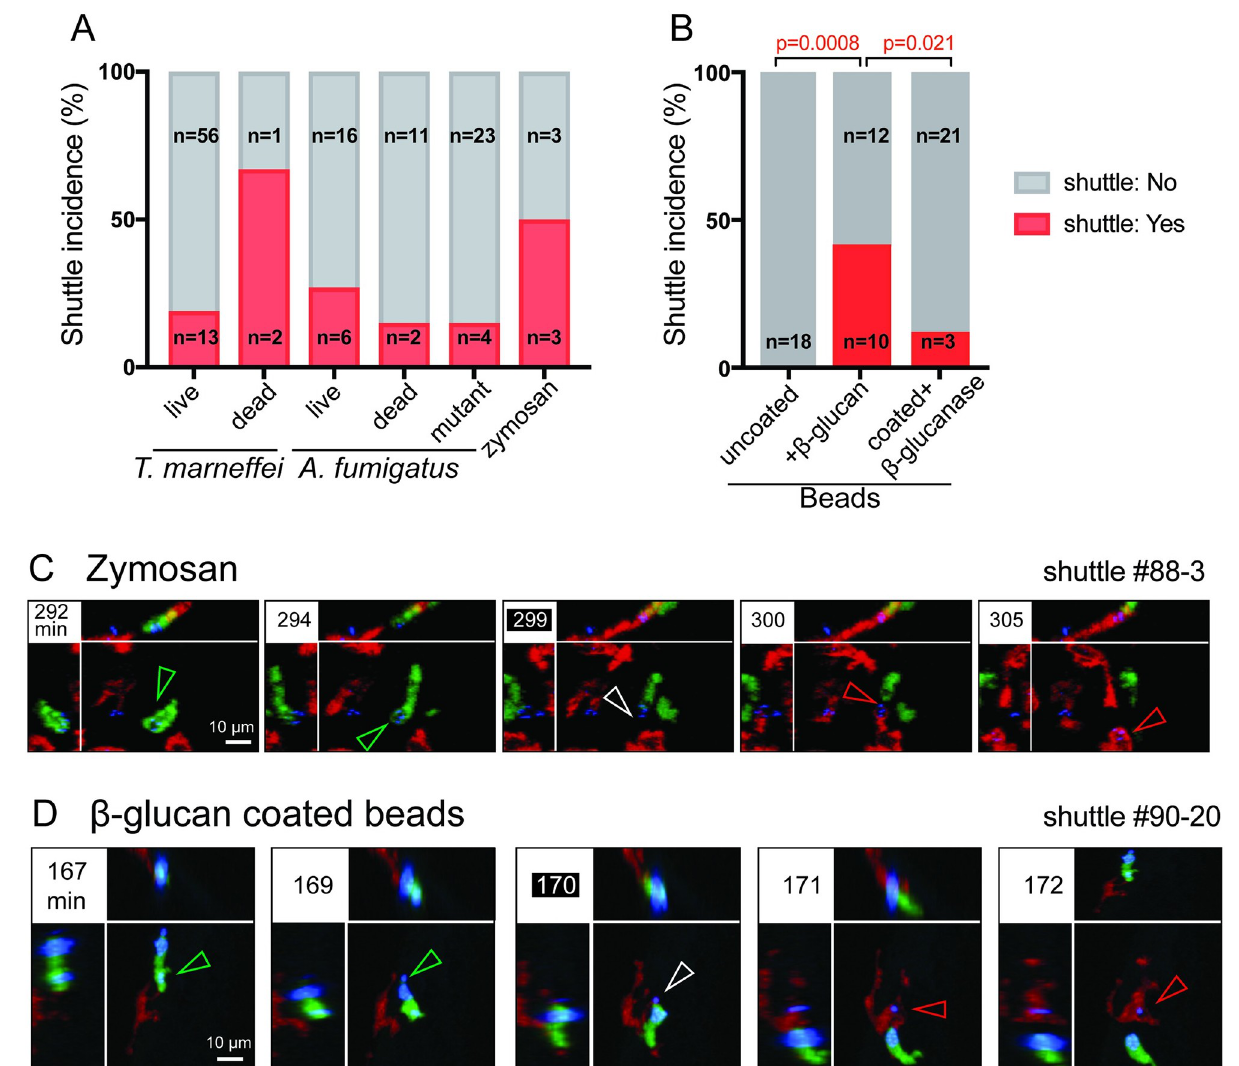
Fig 6. β -glucan is a fungal determinant sufficient to trigger shuttling. (A,B) Relative frequency of shuttles for different cargos, incidence computed for each condition as number of 3-h imaging datasets with shuttle(s)/total number of imaging datasets. By chi-squared analysis, there are no significant differences for the comparisons: live spores of the two species ( p = 0.38), live and dead T . marneffei ( p = 0.31), and dead spores of the two species ( p = 0.34). n -values indicate the number of datasets in each category. (C,D) Images of representative shuttles of zymosan particle (C) and β -glucan– coated plastic beads (D). Shuttles of particles (blue) are from Tg(mpx : EGFP) neutrophils (green) to Tg(mpeg1 : Gal4FF)×(UAS-E1b : Eco . NfsB-mCherry) macrophages (red). In each example, panels include isometric orthogonal yz and xz views corresponding to the xy maximal intensity projection and indicate the time in min from start of movie. Colored arrowheads indicate the conidium within donor neutrophil (green), at the point of intercellular transfer (white) and in the recipient macrophage (red). Scales as shown. Stills in C, D correspond to S5A and S5C Movie, respectively. Datasets for A–B are provided in S1 Data. Eco . Nfsb , E . coli nitroreductase; EGFP, enhanced green fluorescent protein; Gal4FF , engineered form of S . cerevisiae Gal4 transcriptional activator; mpeg1 , macrophage-expressed gene 1; mpx , myeloid-specific peroxidase; Tg , transgenic; UAS-E1b , upstream activating sequence fused to minimal adenovirus E1b